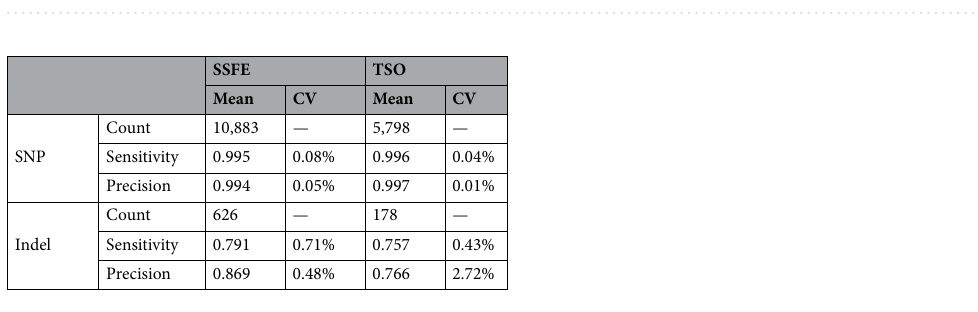
Table 3. Sensitivity and precision of variant detection for the two capture